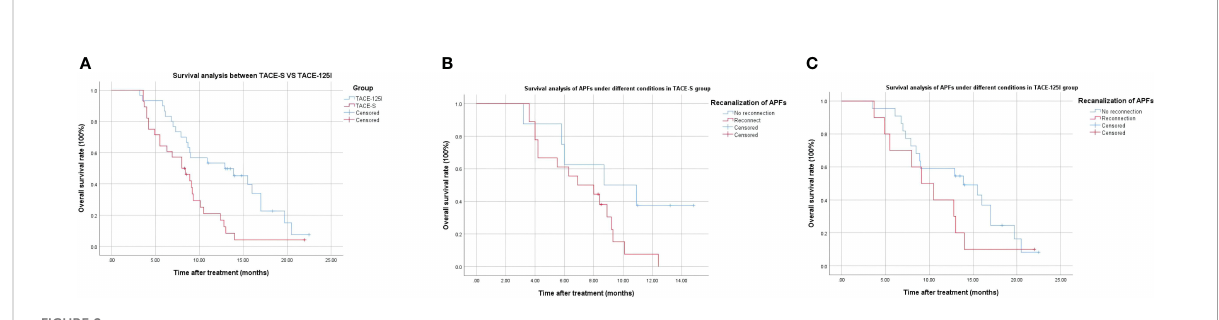
FIGURE 2 Survival curve of patients in TACE-S group and TACE- 125 I